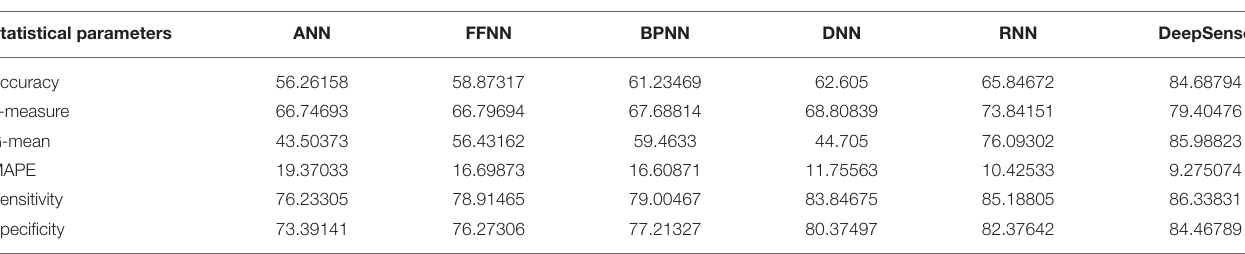
TABLE 2 | Results of statistical parameters for COVID-CT with 70% training data on 1,000 images. Statistical parameters